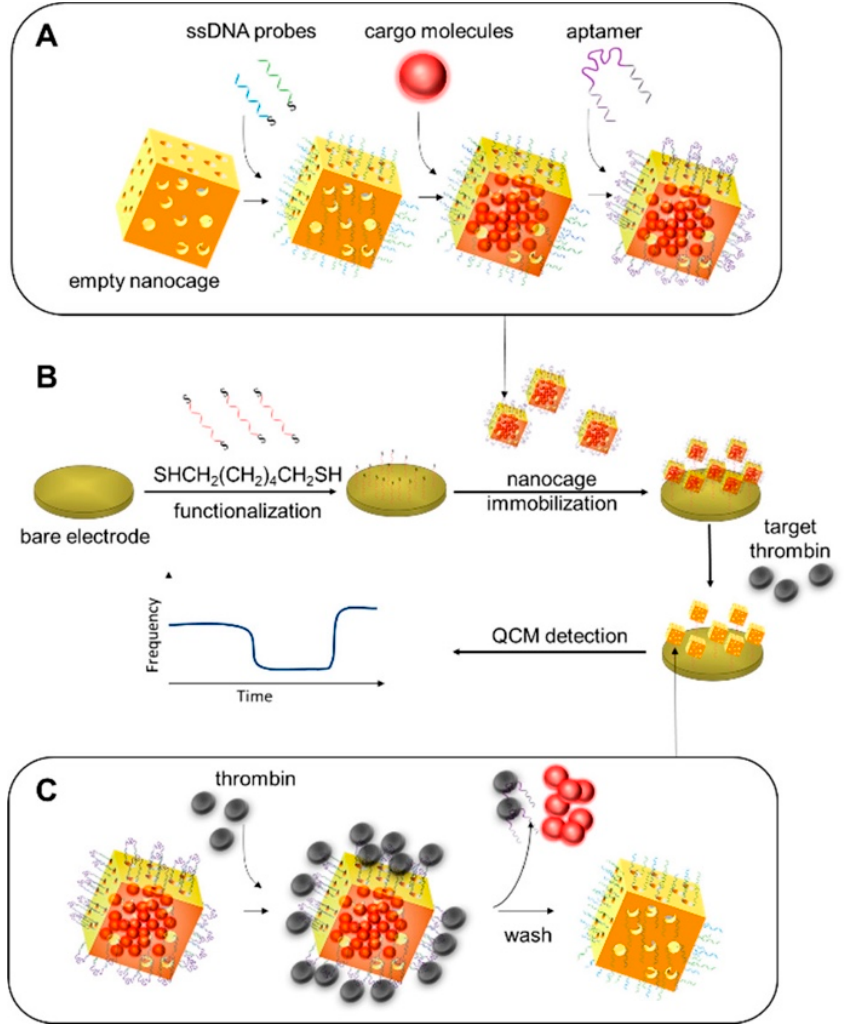
Figure 7. ( A ) Illustration of process of loading cargo molecules into AuNCs; ( B ) preparation of ap- tasensor for detection of thrombin; and ( C ) thrombin-triggered release of cargo molecules. Reprinted with permission from Ref. [126]